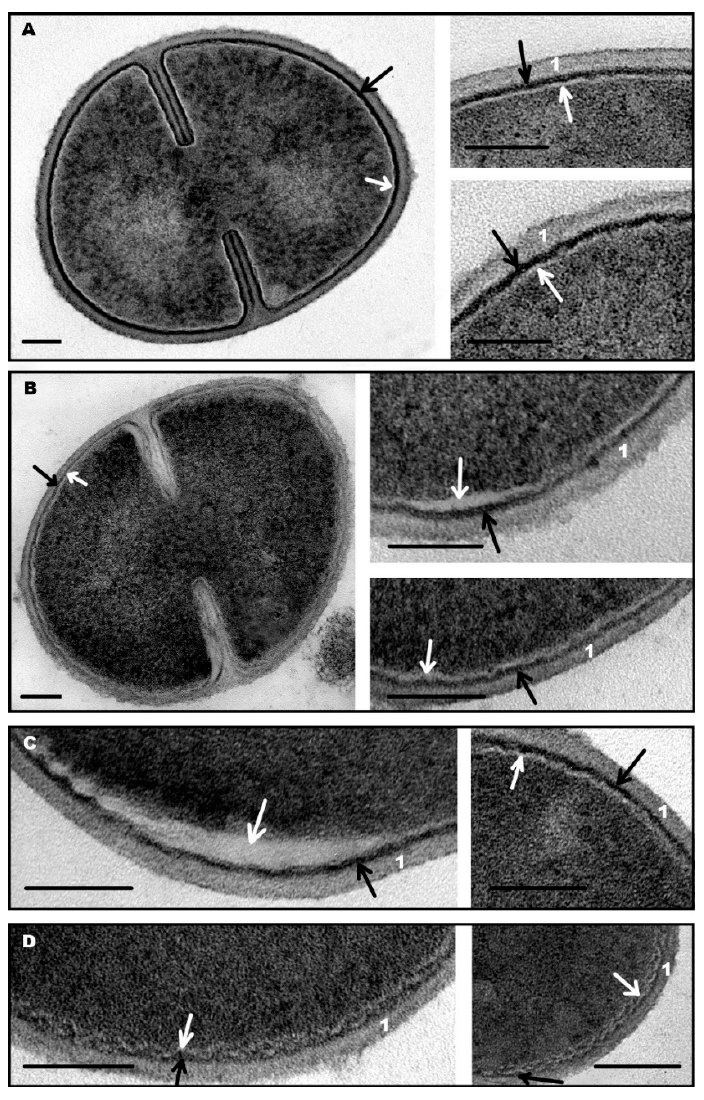
Figure 3. Ultrastructure of S. aureus control cells ( A ); cells after 1 min incubation with R9F2 ( B ) and (KFF)3K peptides ( C , D ). 1—cell wall. Black arrows show intermediate layer; white arrows—electron transparent lipid layer of cell membrane. TEM of ultrathin sections. Scale bars correspond to 100 nm. 3.3. Ultrastructure of S. aureus Treated with Cationic Peptides As expected, R9F2 or (KFF)3K peptides differently damaged S. aureus cells starting from a very early time—one minute after mixing of cell suspension with the peptides.